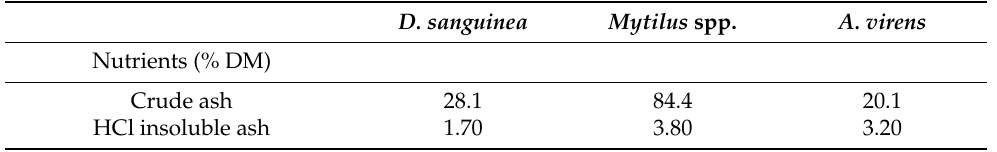
Table 1. Chemical composition of analyzed macronutrients, minerals and selected amino acids of tested organisms used as feed